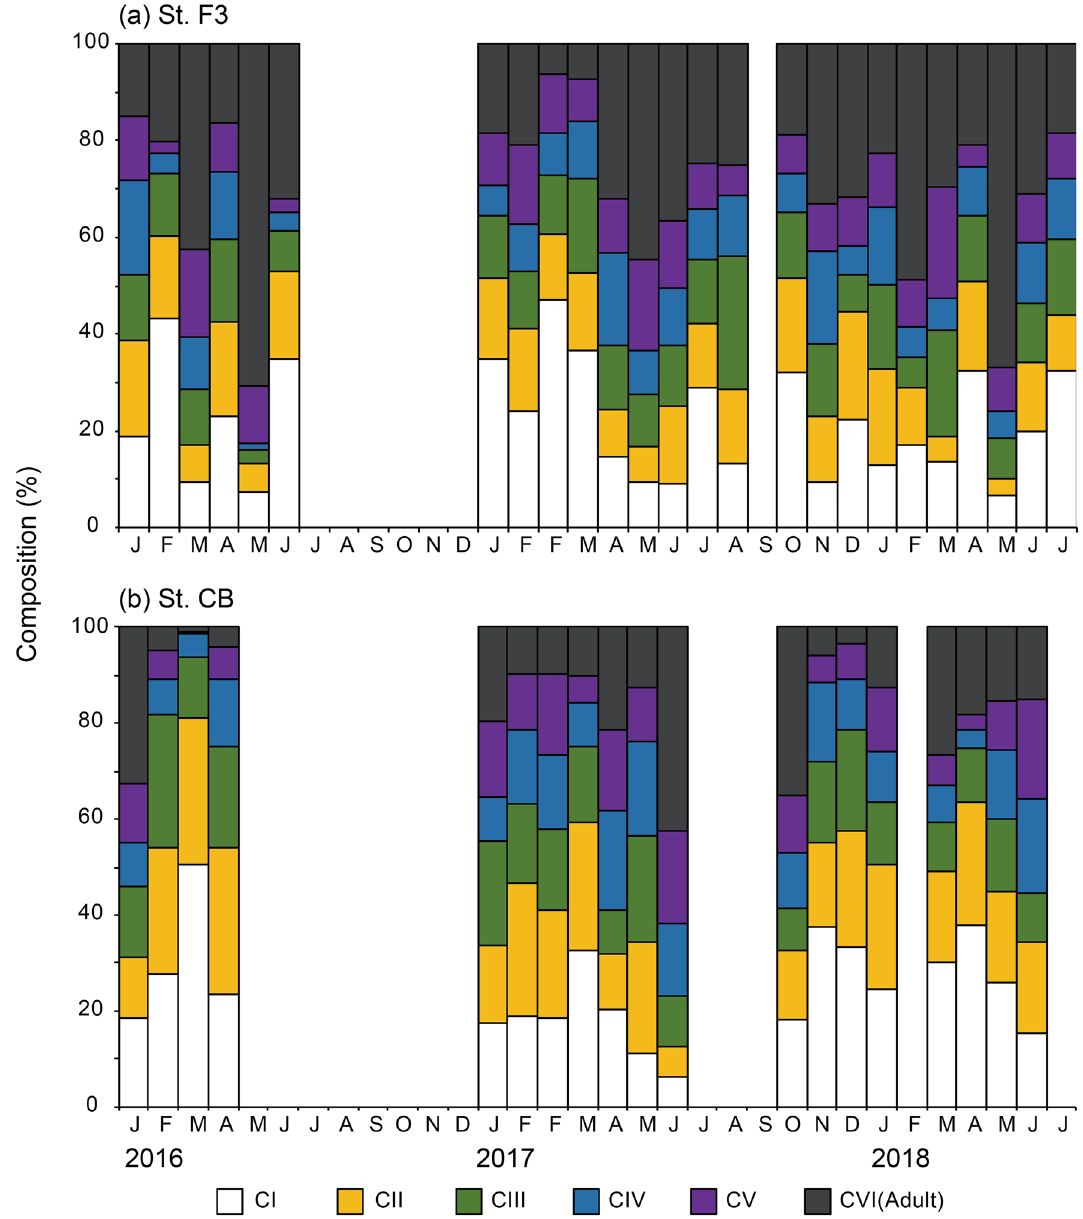
Figure 4. Seasonal changes in the composition of Acartia omorii stage-specific (CI–CVI) abundance at St. F3 ( a ) and St. CB ( b ) from January 21, 2016 through June 26, 2018. In 2017, the first F is on February 6, the second F is on February